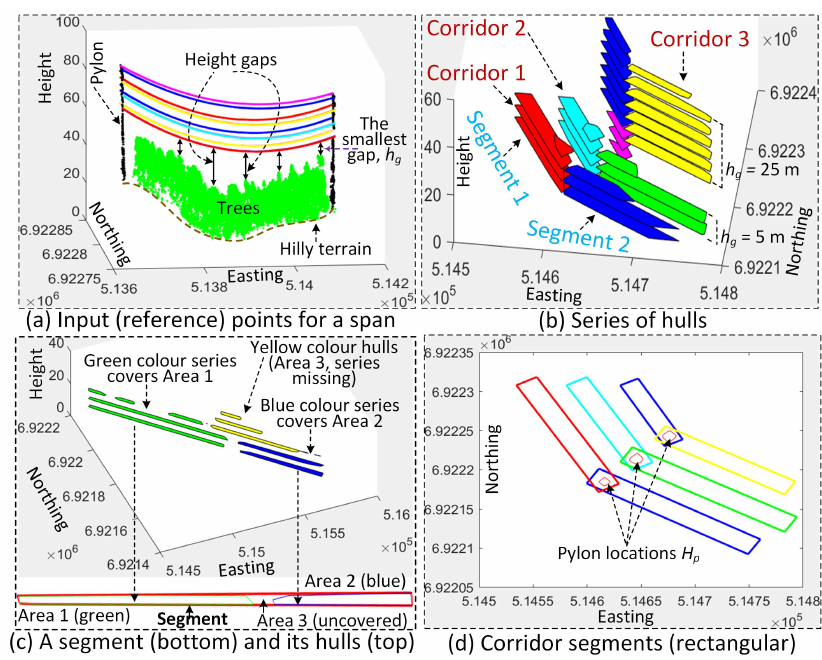
Figure 4. Estimating the height gap. Easting, Northing and Height are in metres (m).